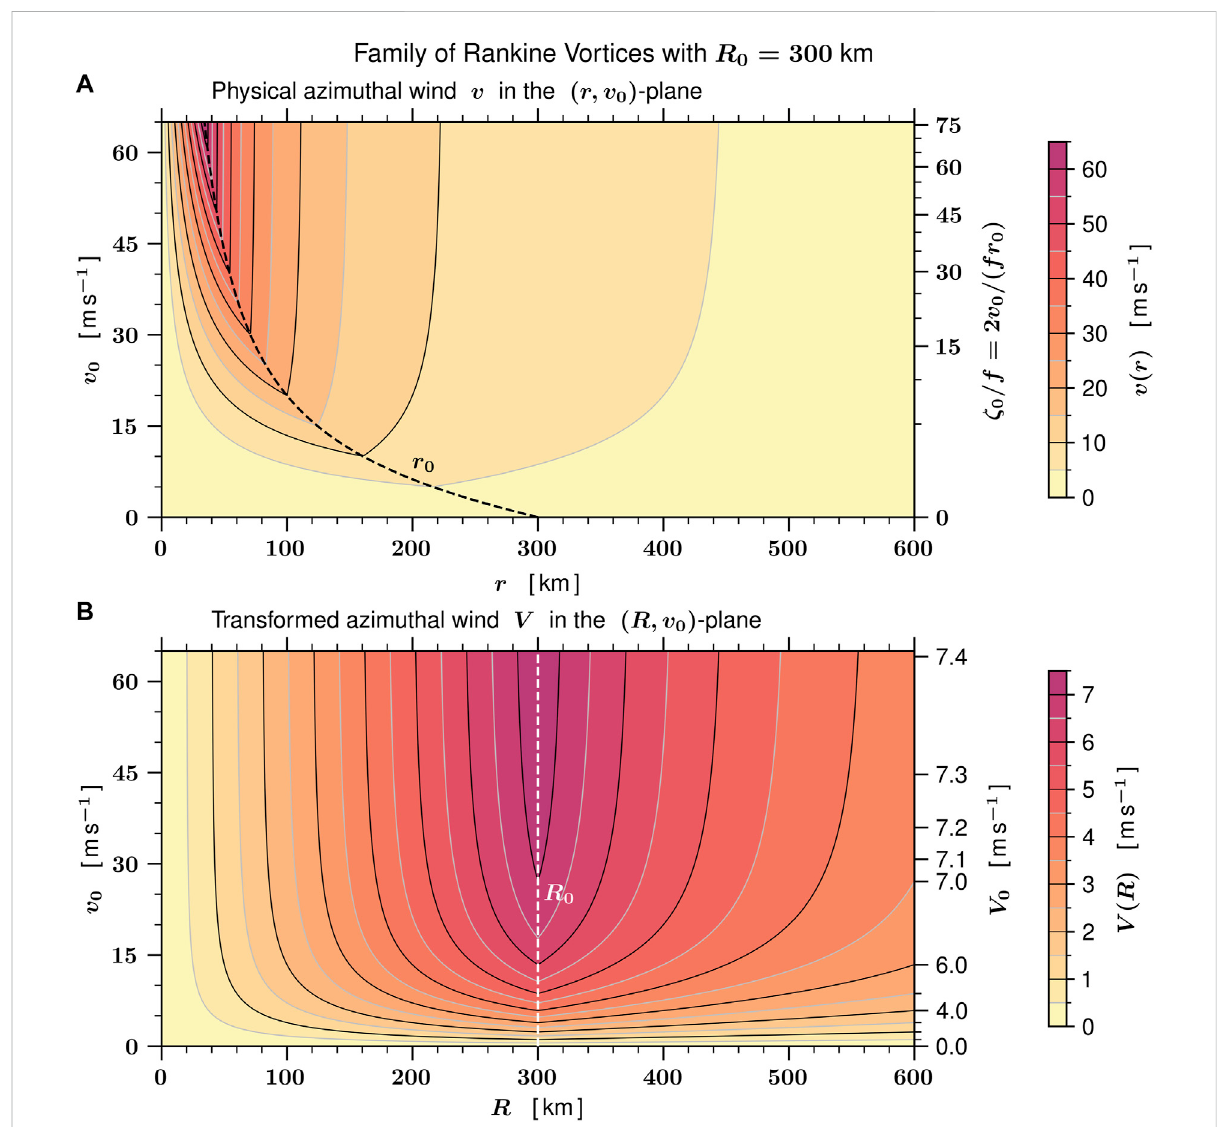
0 )-plane with an isoline interval of